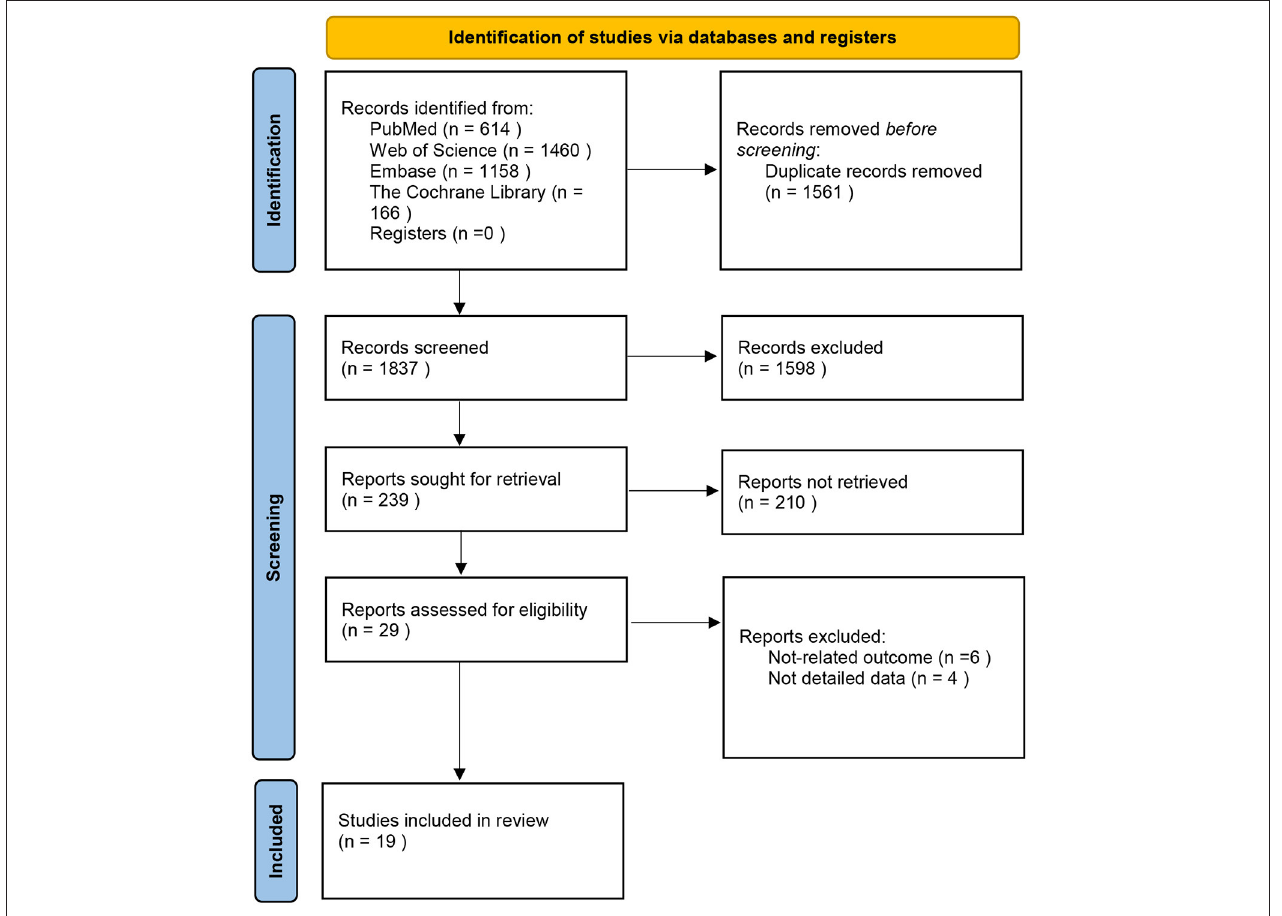
FIGURE 1 | Preferred reporting items for systematic reviews and meta-analyses flow diagram (19).